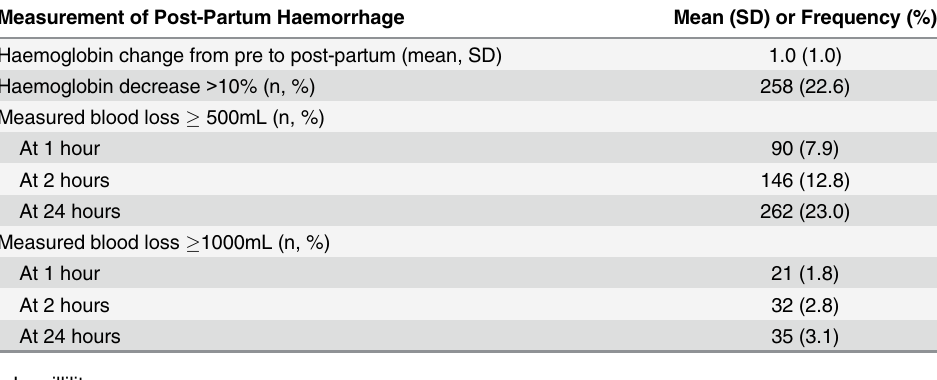
Table 2. Measurement of PPH by haemoglobin drop and measured blood loss. Measurement of Post-Partum Haemorrhage